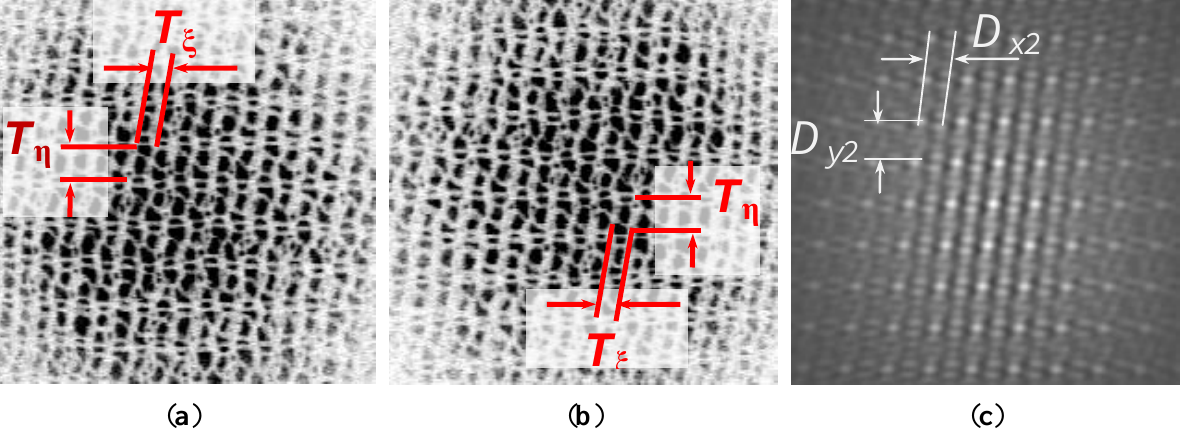
Figure 2. ( a ) The source image of knitted hosiery fabric; ( b ) The resulting image after double Fourier transform without converting complex U to real I ; ( c ) The resulting image after double diffraction pattern calculation using our